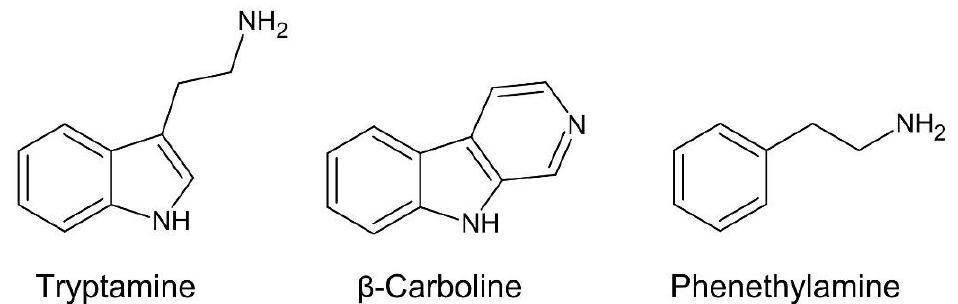
Figure 1. The three major classes of compounds in Acacia, Senegalia and Vachellia.